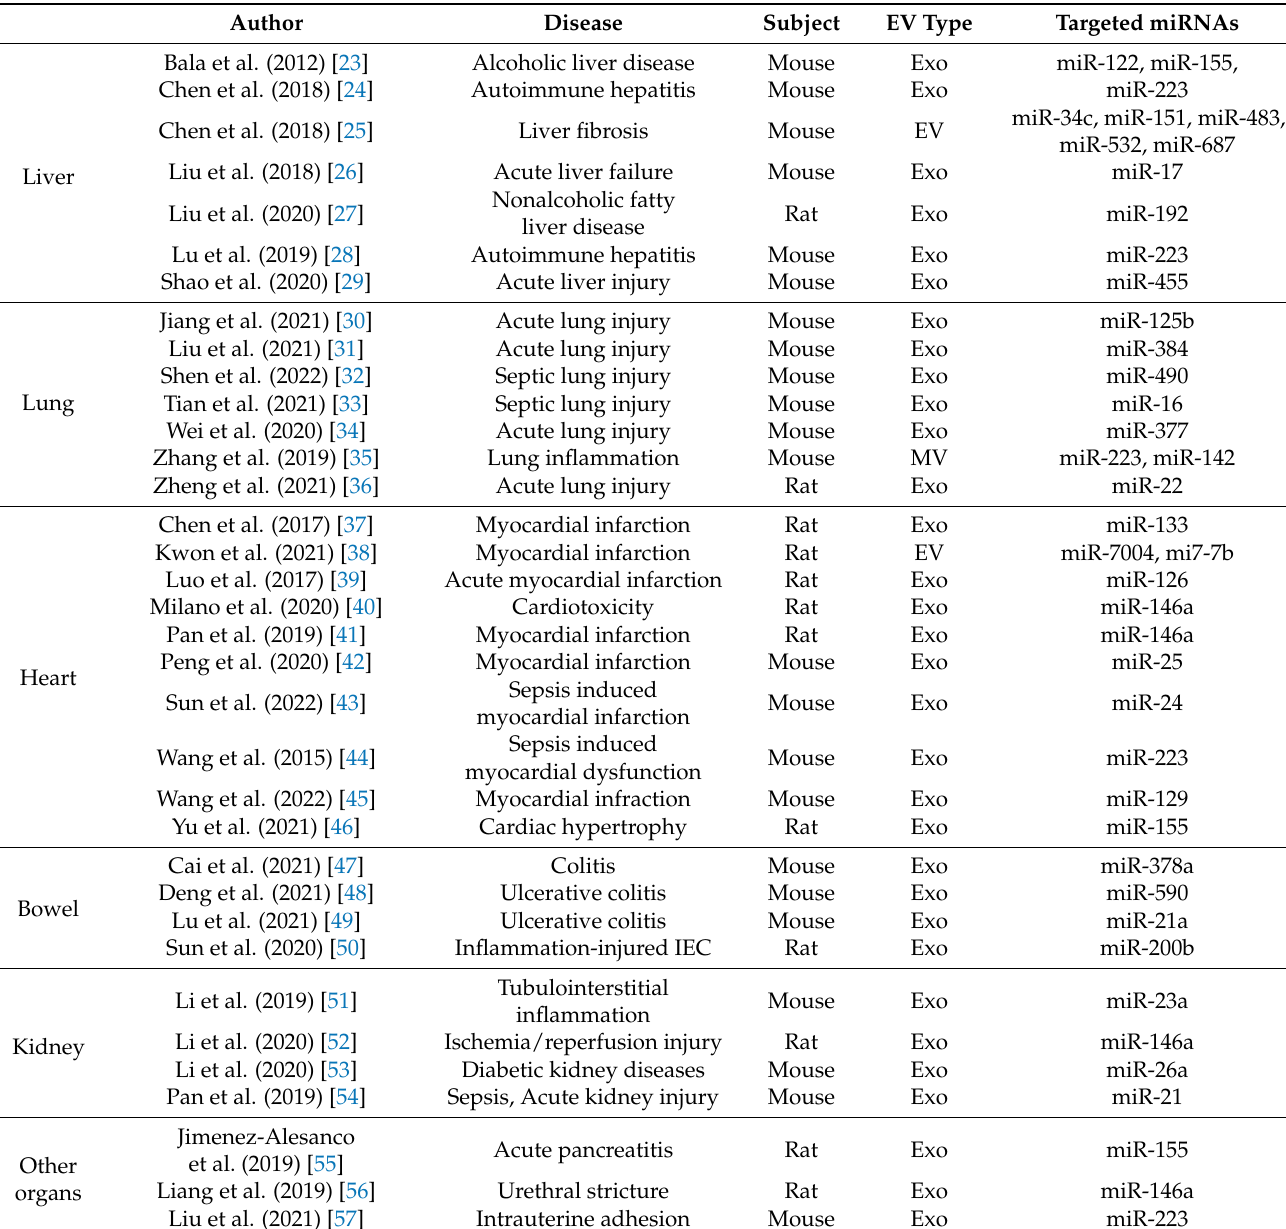
Table 1. Extracellular miRNAs in organ